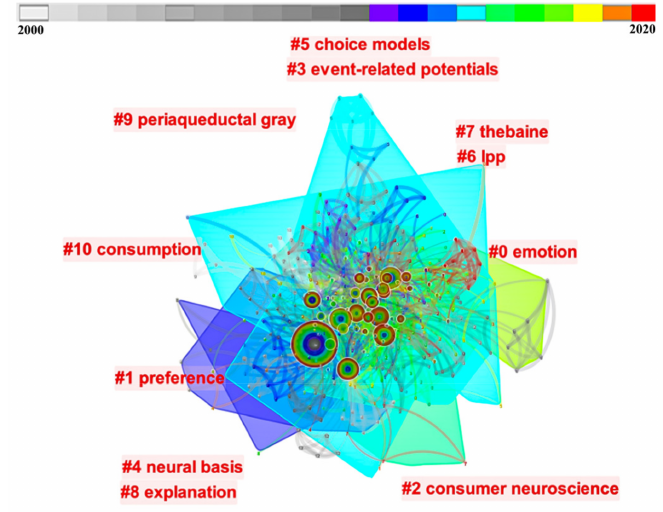
Figure 4. Clusters of related